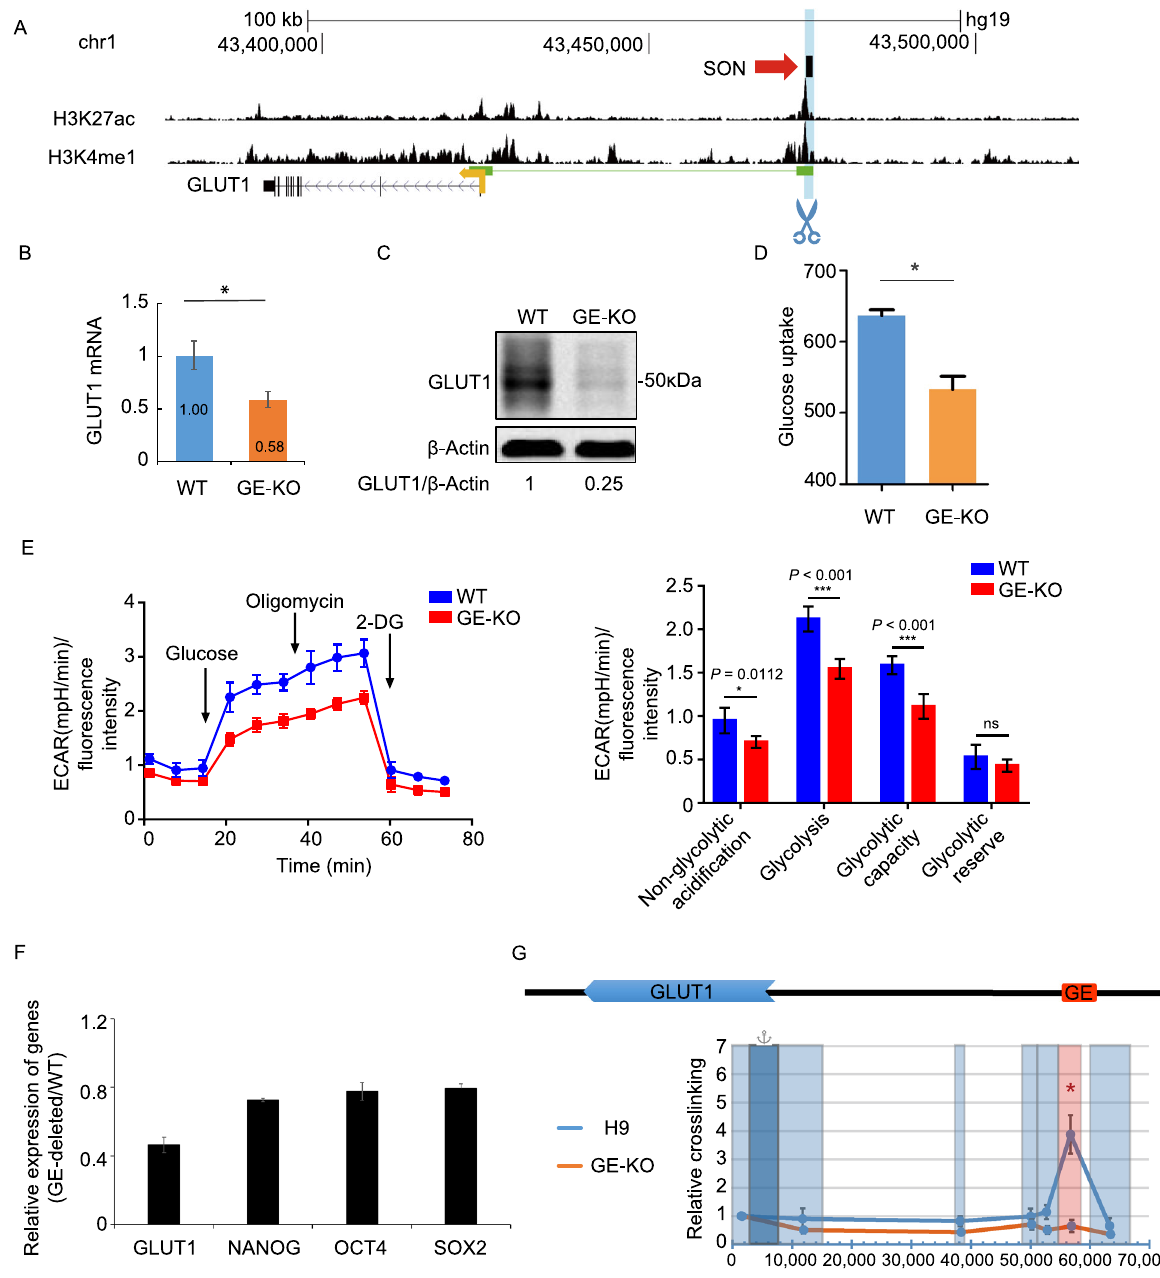
Figure 2. The predicted enhancer of the GLUT1 gene (GE) is required for the expression of GLUT1 in hESCs. (A) The strategy to delete GE in H9 hESCs using CRISPR/CAS9 technology. The top panel shows the SON binding site and the epigenetic pro fi les for H3K27ac and H3K4me1. The deleted region is indicated in light blue. (B) Deletion of GE in hESCs reduced the mRNA levels of GLUT1. GE-deleted hESCs are denoted GE-KO hESCs. Data represent mean ± SEM. n = 3. (C) Deletion of GE in hESCs reduced the protein levels of GLUT1. (D) Deletion of GE in hESCs reduced glucose uptake. Data represent mean ± SD. n = 4. (E) Deletion of GE in hESCs signi fi cantly reduced their ECAR. Data represent mean ± SD. n = 6. (F) The deletion of GE reduced the mRNA expression levels of pluripotency genes in hESCs. Data represent mean + SD. n = 3. (G) Deletion of GE greatly reduced the long- distance chromosomal interaction between promoter and GE region of the GLUT1 gene. The GLUT1 promoter area is indicated by dark blue and the target restriction fragments light blue. GE-containing restriction fragment is indicated by red color. Primers were all forward orientation and positioned at the right end of each restriction fragment. Data represent mean ± SEM. * P ≤ 0.05 by two-tailed Student ’ s t test comparing WT to GE-KO. n =